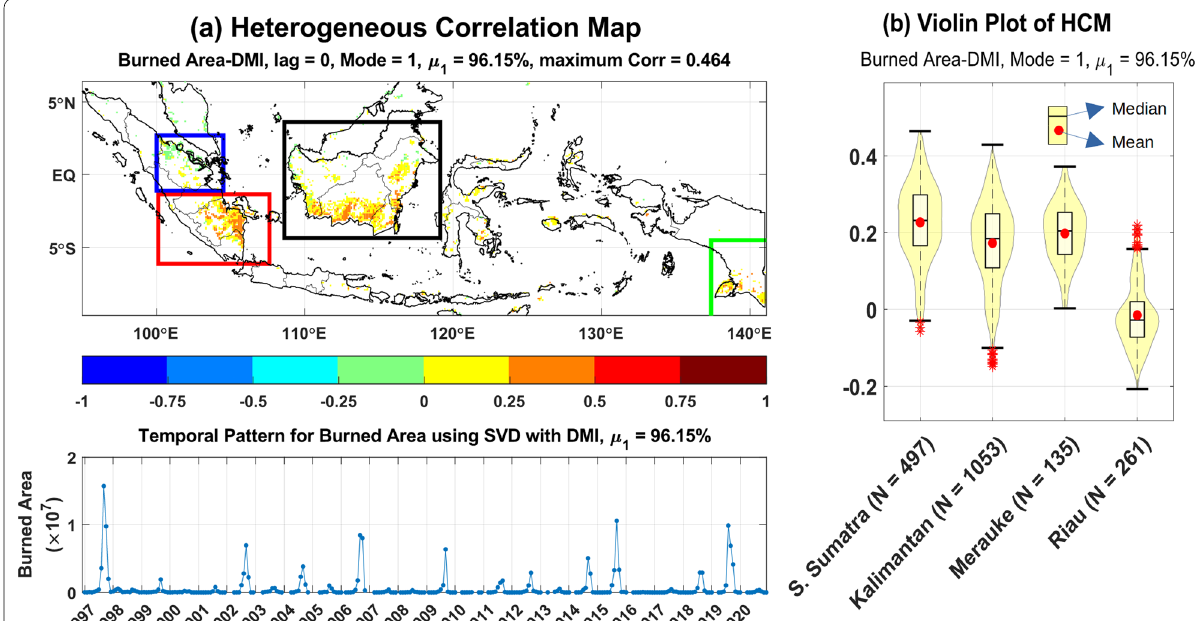
Fig. 2 The correlation map between burned area and DMI: a the HCM and burned area principal temporal pattern b violin plot of correlation coefficient on Riau (blue box), South Sumatra (red box), Kalimantan (black box), and Merauke (green box). Red dots and stars represent the average value and outlier of correlation distribution in each